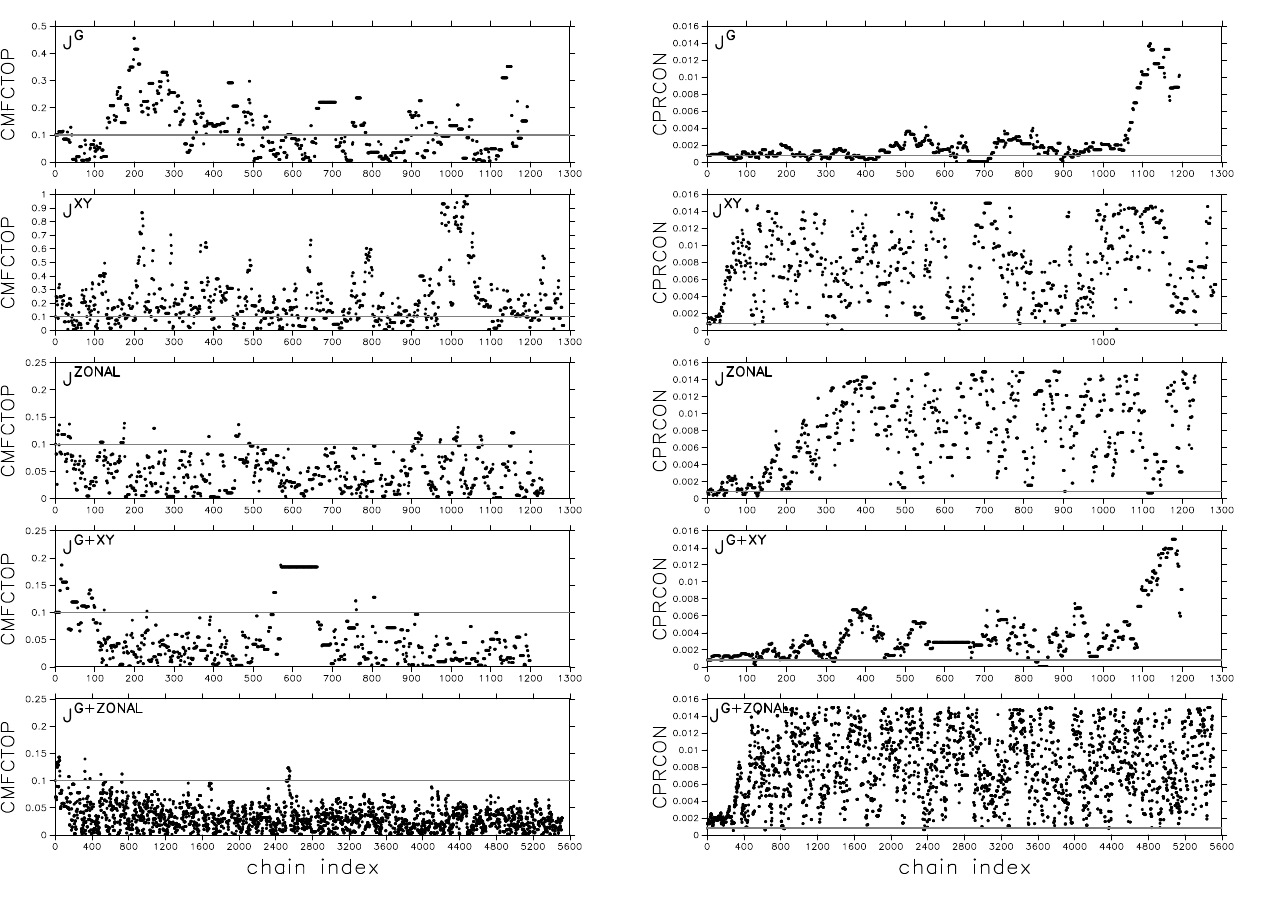
Fig. 1. The MCMC chain for parameter CMFCTOP. The horizon- tal grey line at parameter value 0 . 1 is the default value. Note the different scaling in different panels. Also note that the length of the MCMC chains is slightly larger than the number of ECHAM5 runs performed (1000 for the first four chains, 4500 for the J G + ZONAL chain).